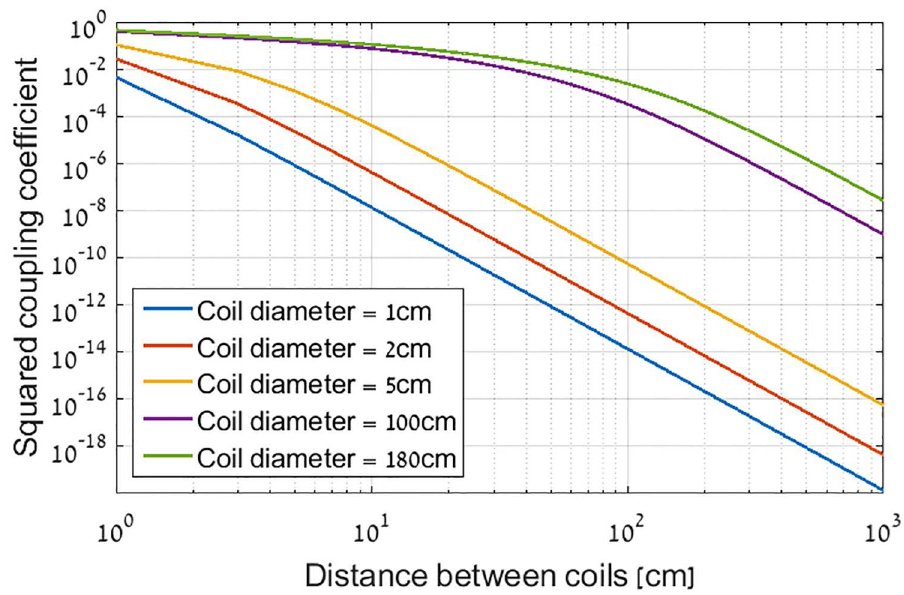
Fig 14. Maximum coupling coefficient of various coaxial coils as function of distance between